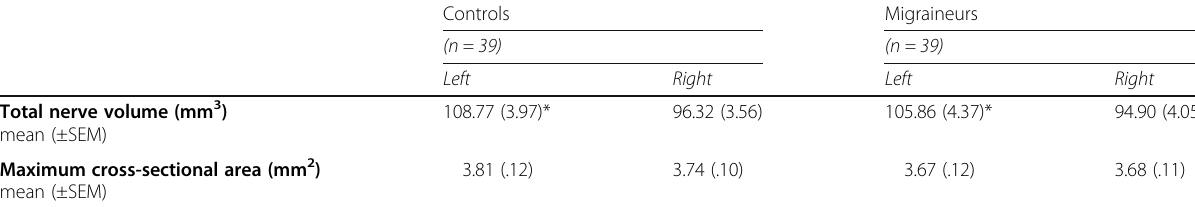
Table 1 Overall mean (SEM) volume and maximum cross-sectional area of the trigeminal root entry zone in control and migraine subjects